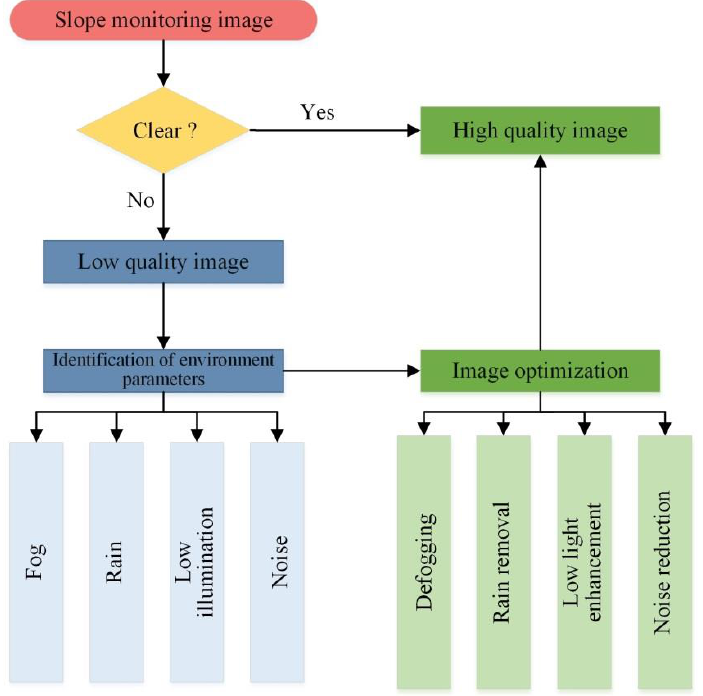
Figure 9. The process of slope monitoring image